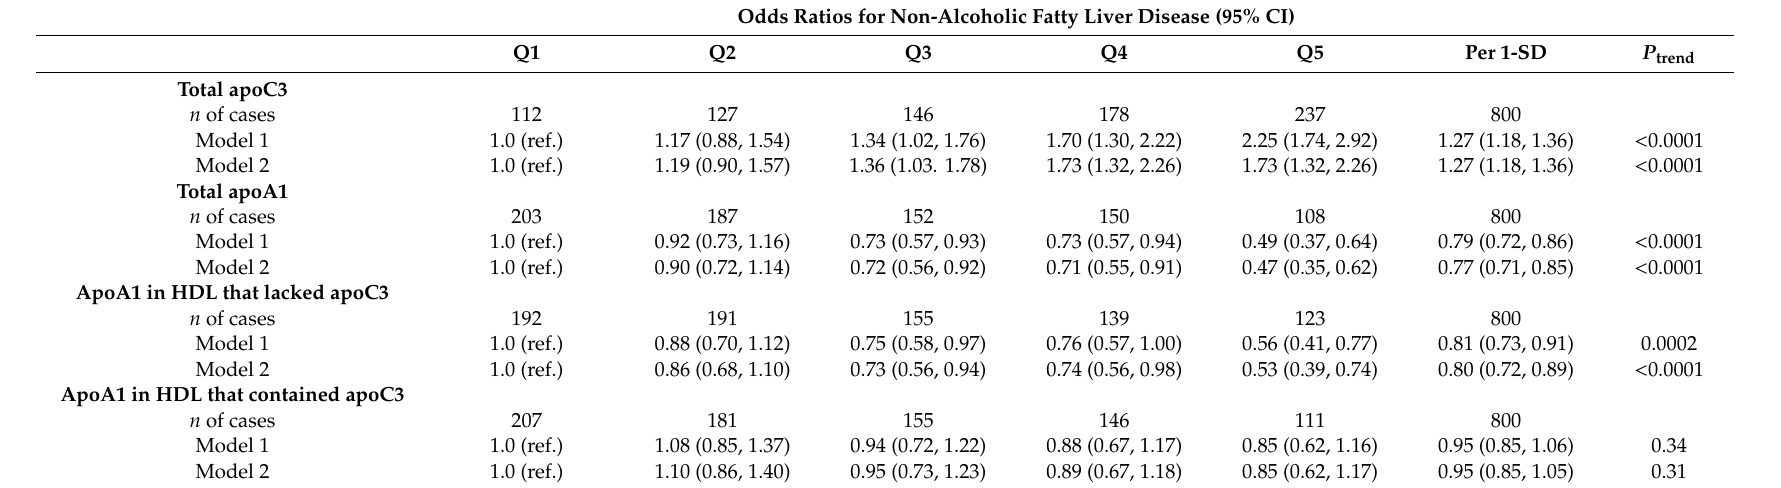
Table 3. Odds ratios for non-alcoholic fatty liver disease by apolipoprotein quintile in